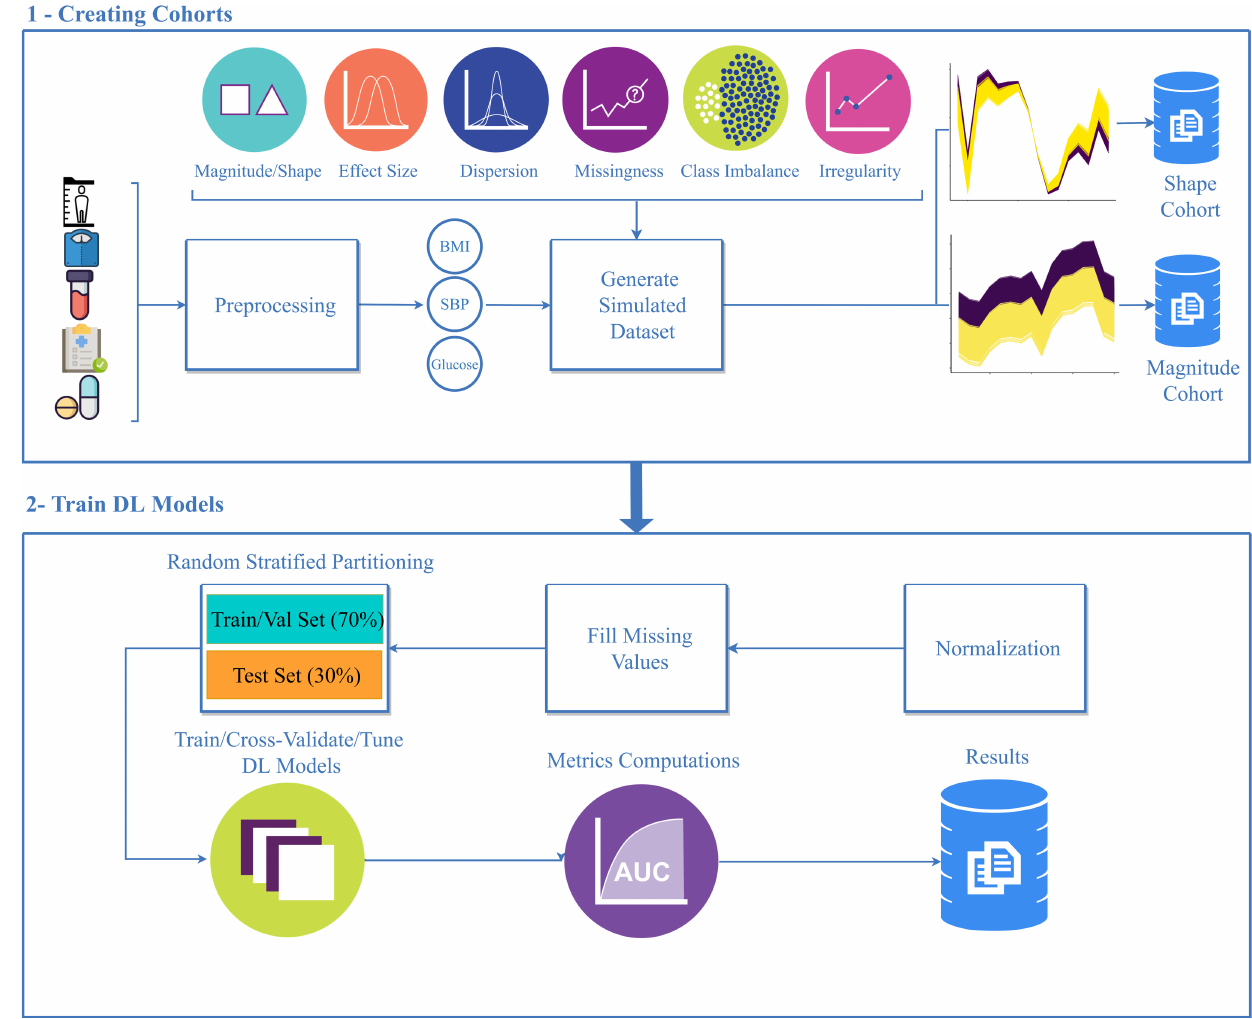
Fig. 1 Simulation study work fl ow. In the fi rst step, longitudinal electronic health record (EHR) data were collected from six randomly selected patients and used to generate reference body mass index (BMI) trajectories using weight and height measurements. Magnitude and shape simulation cohorts were generated from the reference trajectories. Subsequently, simulation cohorts are used to train deep learning models after Z-score normalization, missing value imputation, and partitioning data into training/test sets. Cohorts were randomly partitioned to have training/validation, and test sets of 70%, 30%